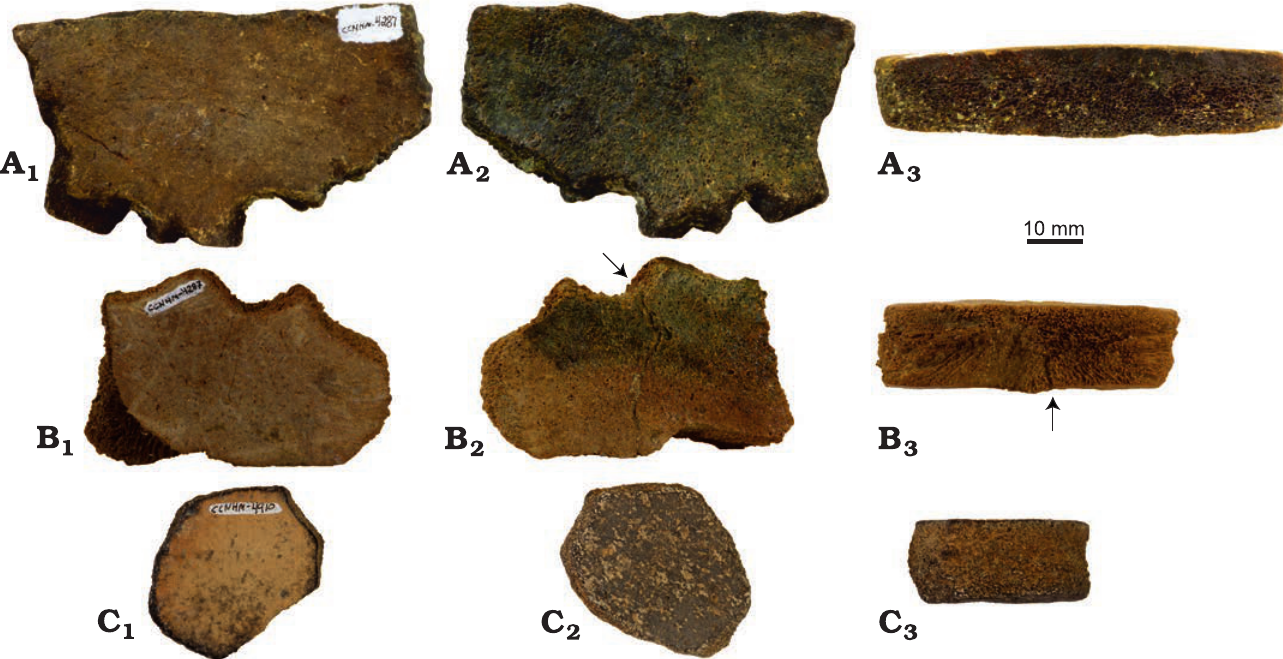
Fig. 3. Ossicles of leatherback turtle Natemys sp. 2 from Oligocene of South Carolina, USA. CCNHM 4287.1 ( A ), CCNHM 4287.2 ( B ), and CCNHM 4910 ( C ), in dorsal (A 1 –C 1 ), visceral (A 2 –C 2 ), and sutural (A 3 –C 3 ) views. Arrows indicate the fissure on the visceral and sutural surfaces of CCNHM 4287.2, and note the stratified internal structure of CCNHM